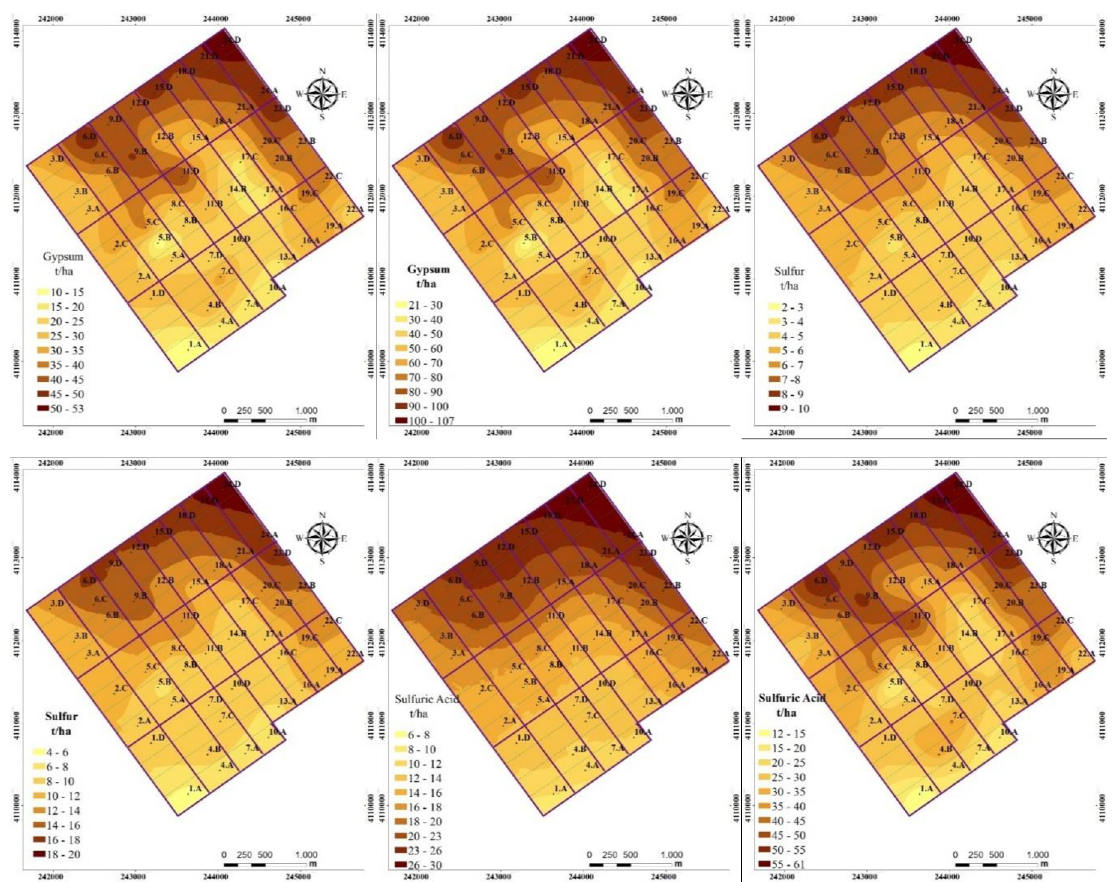
Fig 5. Spatial distribution maps for the amount of gypsum, elemental sulfur and sulfuric acid calculated for 60 and 120 cm depth of soils profile.